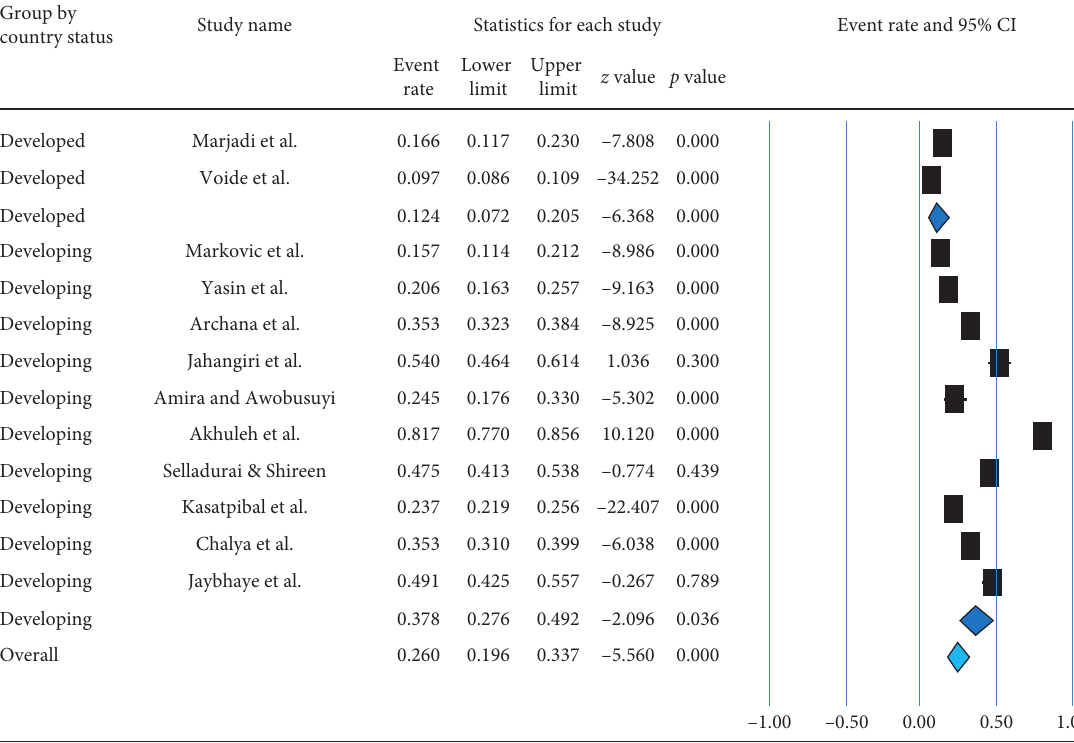
Figure 7: Forest plot shows the subgroup analysis of pooled prevalence of needle stick injury in the previous one year based on so- cioeconomic